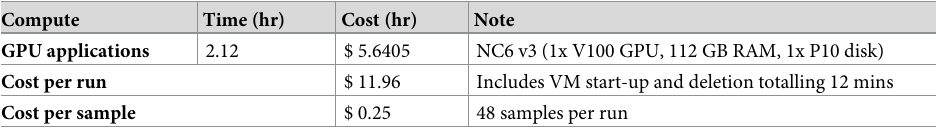
Table 3. Estimation of running cost per